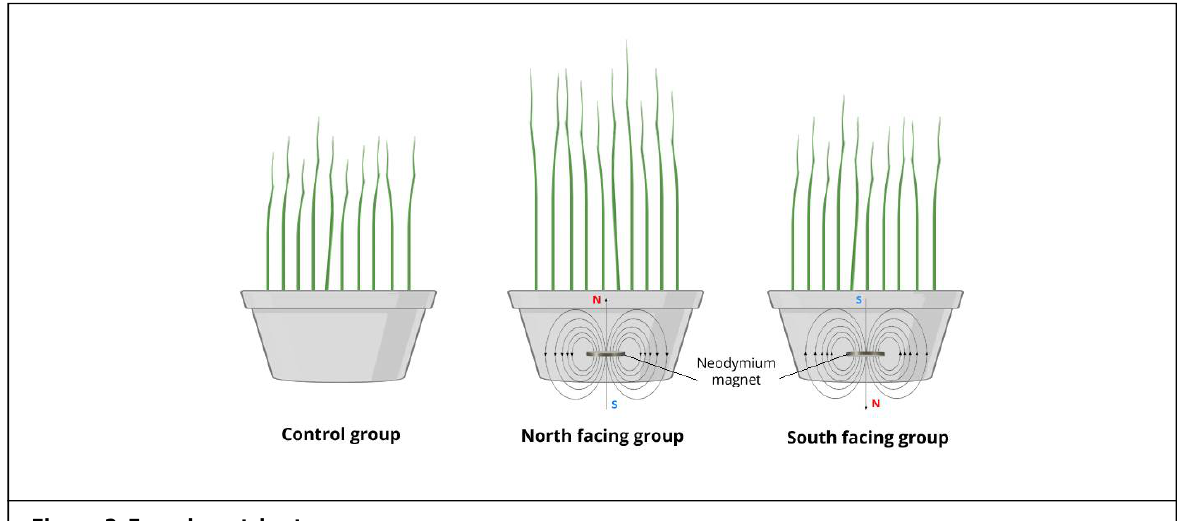
Figure 2: Experimental setup